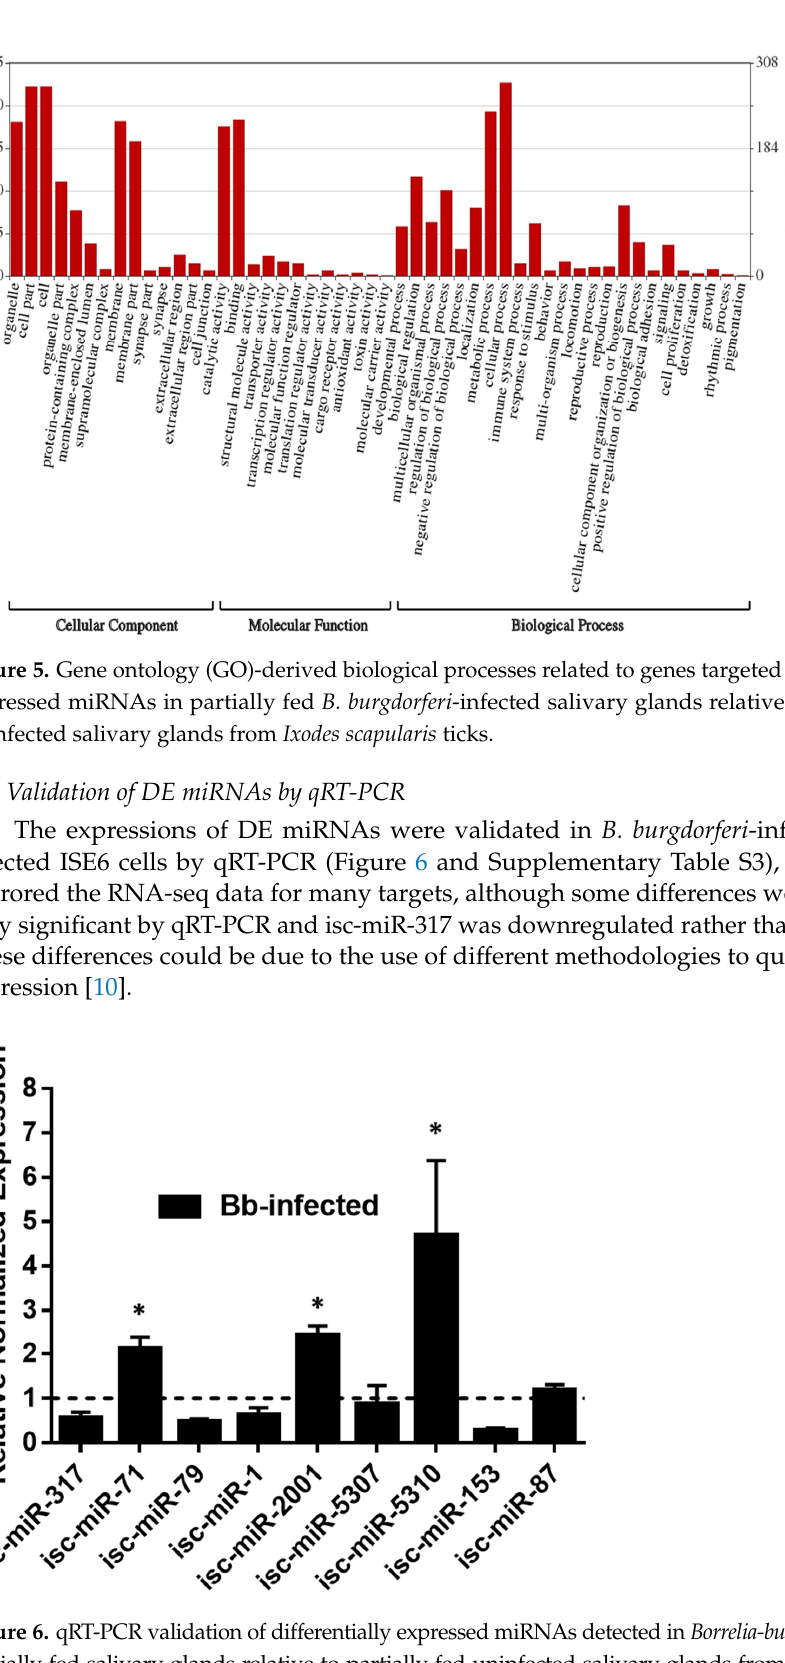
Figure 6. qRT-PCR validation of differentially expressed miRNAs detected in Borrelia-burgdorferi- infected, partially fed salivary glands relative to partially fed uninfected salivary glands from